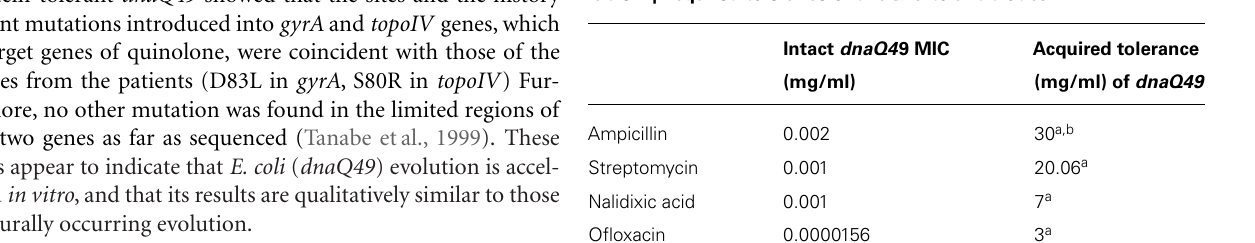
of all two-error mutants (I 2 ), etc. are plotted. (A) c = 0 or the parity model; (B) c = 0.09; (C) c = 0.1; and (D) c = 0.3. Arrow indicates the error threshold. For details see text. Adapted from Aoki and Furusawa (2003); permitted to use this figure from APS Journal, ASP Copyright 2003.